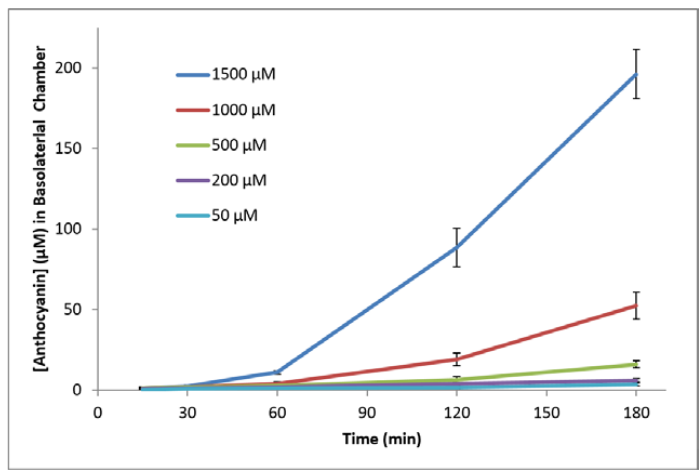
Figure 2. Effect of time on the concentration (µM) of anthocyanins transported through the NCI-N87 monolayer (apical to basolateral chambers) at apical pH 3.0, with varying initial concentrations over 3 h at 37 °C.